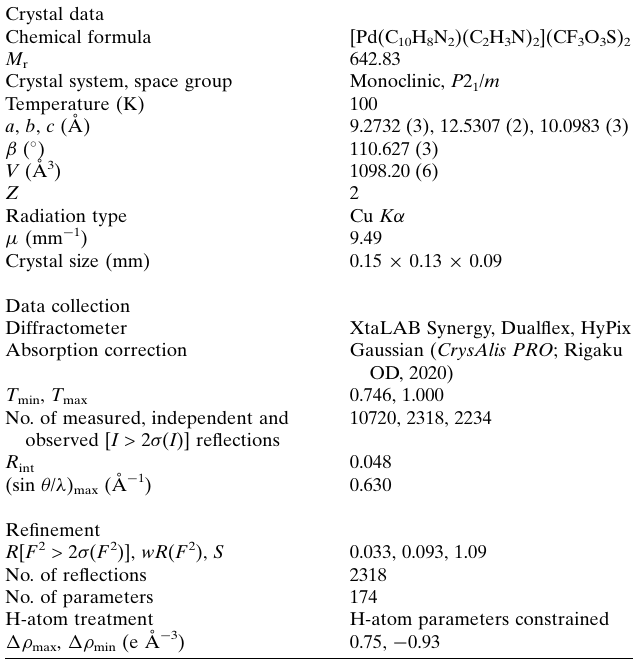
Table 2 Experimental details. Crystal data Chemical formula